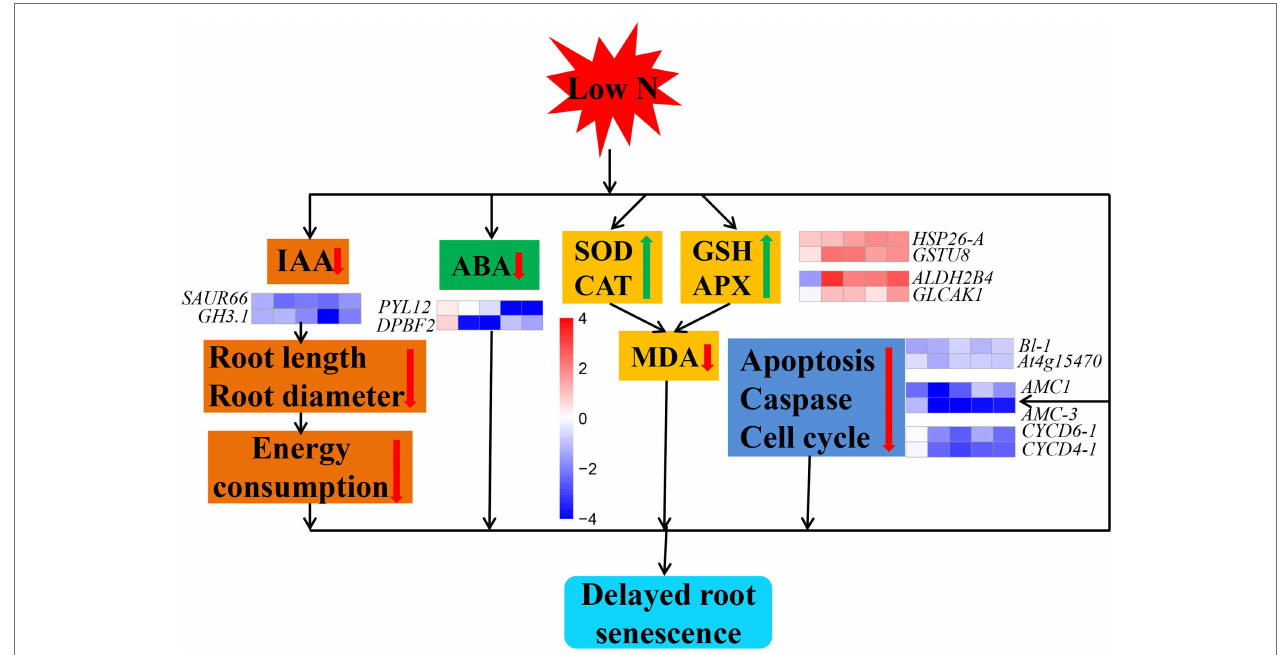
FIGURE 12 | Model showing the mechanism of cotton root senescence under nitrogen stress. The red and green arrows represent a decrease and increase in an indicator, respectively. Cubes represent the value of log 2 fold change (from left to right: comparisons between low nitrogen and normal nitrogen treatment at 20, 40, 60, 80, and 100 DAE). Red color indicates upregulated, while blue indicates